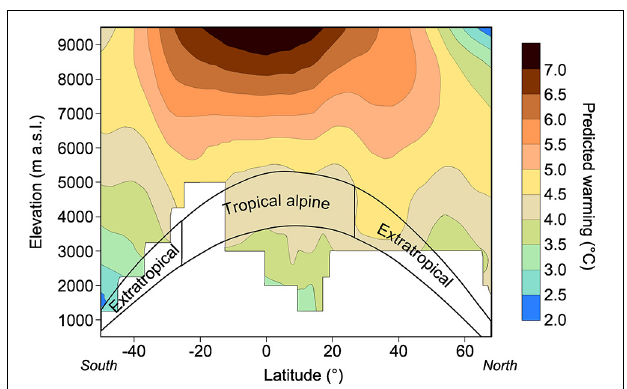
FIGURE 5 | Projected temperature warming along a latitudinal gradient and an elevation gradient, with a focus on alpine regions, worldwide [from 1990–1999 to 2090–2099, based on the 4th assessment report of the Intergovernmental Panel on Climate Change (IPCC)]. Modified from Körner (2003) and Bradley et al.